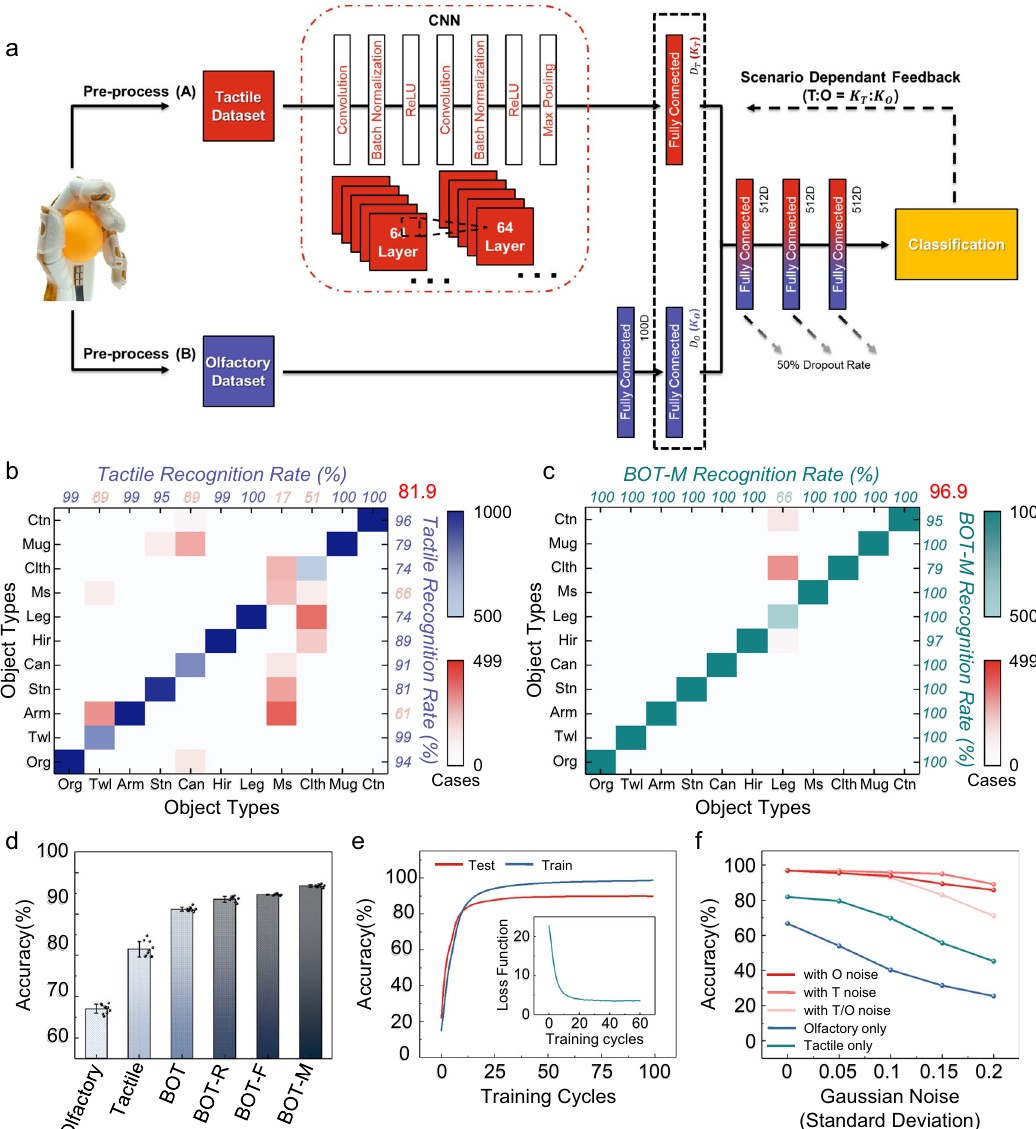
Fig. 3 BOT associated learning for object classi fi cation. a Scheme showing how tactile and olfactory information is processed and fused in the BOT associated learning architecture. 512D, 512-dimensional vector; 100D, 100-dimensional vector. b Confusion matrix of the sole tactile recognition strategy. c Confusion matrix of the BOT-M recognition strategy. The full name of the abbreviation: Org-Orange; Twl-Towel; Arm-Arm; Stn-Stone; Can-Can; Hir-Hair; Leg-Leg; Ms-Mouse; Clth-Worn Clothes; Mug-Mug; Ctn-Carton. d BOT-M associated learning shows the best accuracy among the unimodal (tactile and olfactory) and multimodal fusion strategies (BOT, BOT-R, BOT-F, BOT-M). n = 10 for each group. The error bars denote standard deviations of the mean. Unimodal strategies: olfactory-based recognition using only olfactory data and tactile-based recognition using only tactile data. Multimodal fusion strategies using both tactile and olfactory data: BOT associated learning fusion, fusion based on random points (BOT-R), fusion based on feature point selection (BOT-F), fusion based on feature point selection and multiplication (BOT-M). The fi nal recognition accuracies are 66.7, 81.9, 91.2, 93.8, 94.7, and 96.9% for olfactory, tactile, BOT, BOT-R, BOT-F, and BOT-M strategies, respectively. e The change in recognition accuracy of the BOT-M neural network with the increase of training cycles. Inset: Loss of function variation during the training process. f The testing results of tactile-, olfactory-, and BOT-M- based strategies under defective tactile and olfactory information with various Gaussian noises (0.05, 0.1, 0.15, and 0.2) show that BOT-M can maintain higher recognition accuracy with increased noise levels compared to unimodal fusion